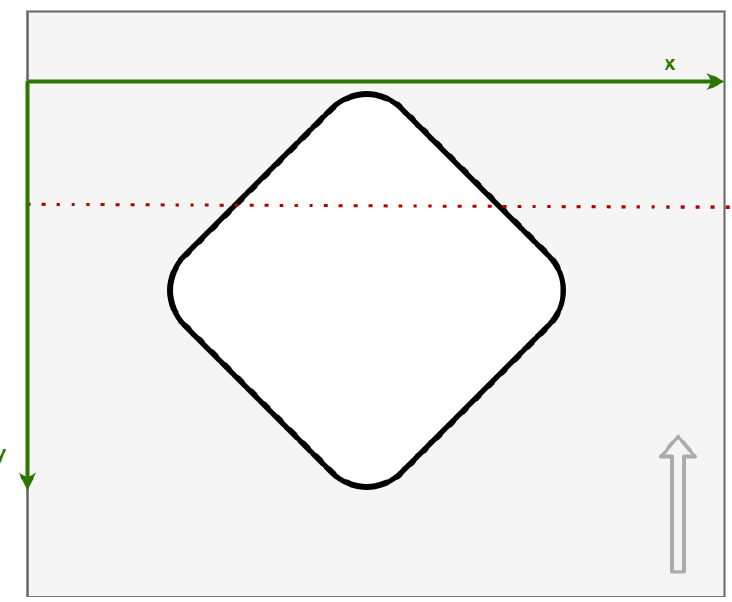
Figure 7. Example of object scan.